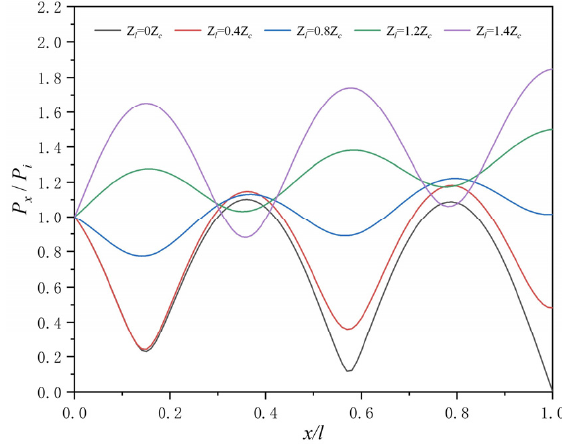
Figure 12. Wave amplitude distribution when the wave frequency is 1 Hz.